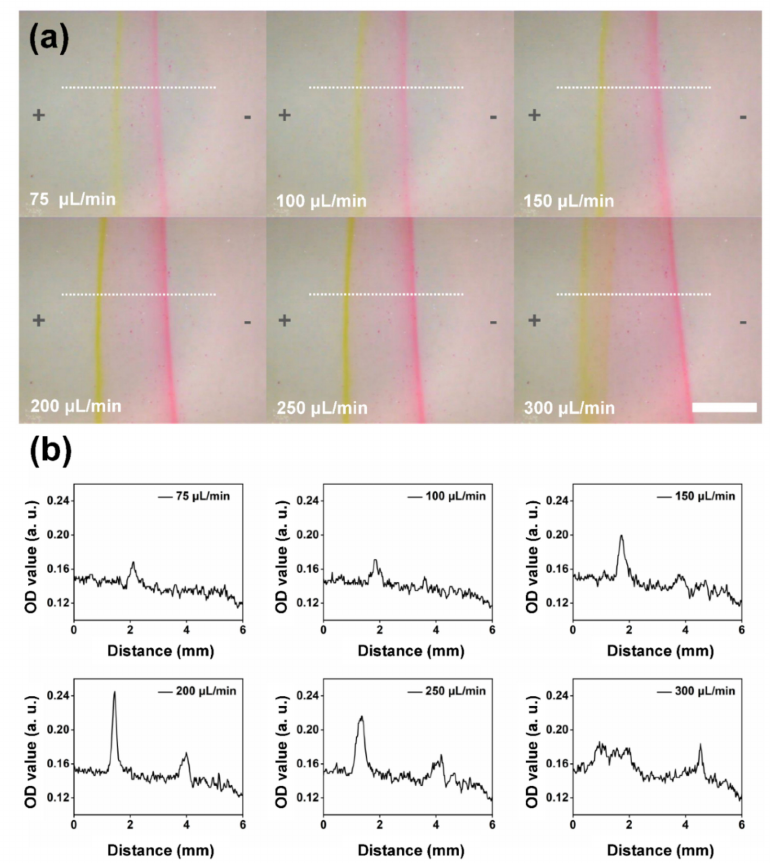
Figure 5. ( a ) Optical micrographs of the sample solution (the mixture solution of Rh6G and NaFL) in the separation chamber at an applied voltage of 150 V with different flow rates of the sample solutions ranging from 75 µ L/min to 300 µ L/min. The flow rate of the buffer solution was set at 3 mL/min. The direction of the electric field was from left (+) to right ( − ). Scale bar: 2.5 mm. ( b ) Optical density (O.D.) value versus the horizontal distance along the separation chamber estimated from the dashed line in ( a ) with different flow rates of the sample